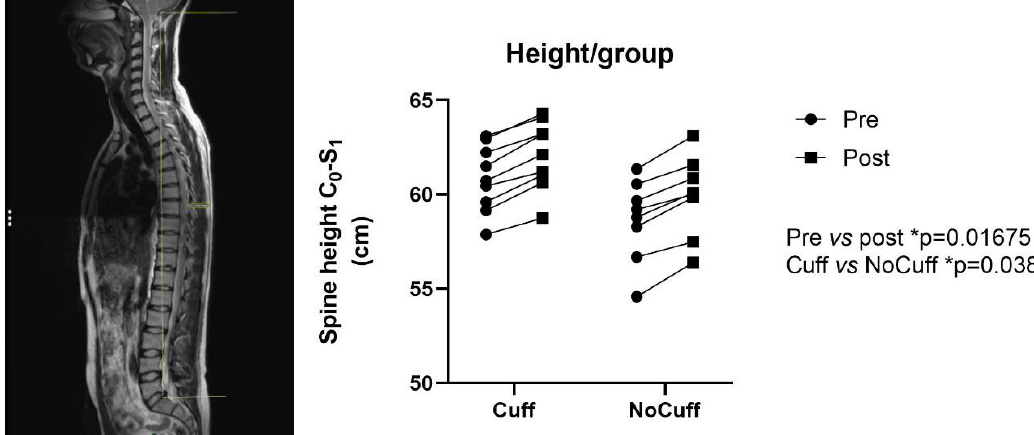
Figure 1. Magnetic resonance imaging (MRI) T2 sagittal sequence centered in the median plane. Spine height (distance occipital bone C 0 to first sacral vertebra S 1 as shown in yellow line) increased for each of subject, with a mean change from 59.81 to 61.06 cm (95% confidence interval (CI) of difference 1.428 to 1.065 cm; * p < 0.05).